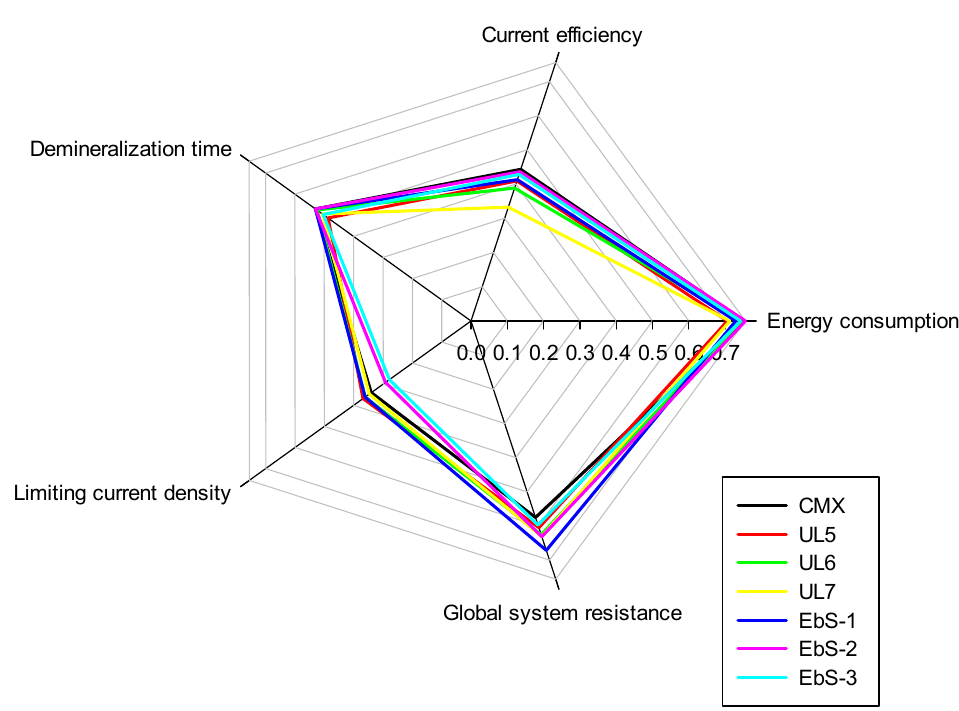
Figure 8. Radar graph of the global ED performance of hIEMs and CMX.